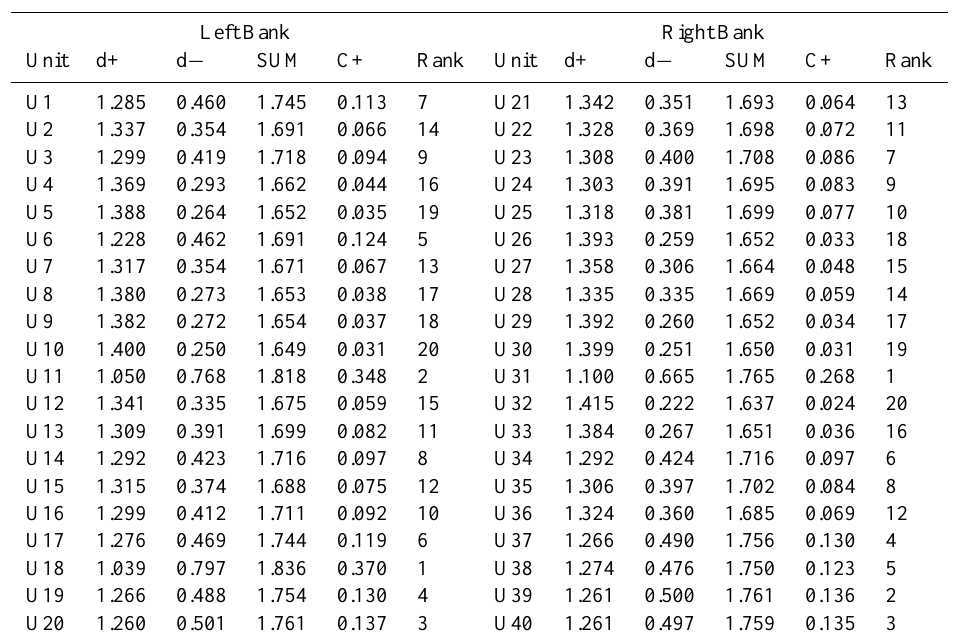
Table 6. Similarities and rankings of all